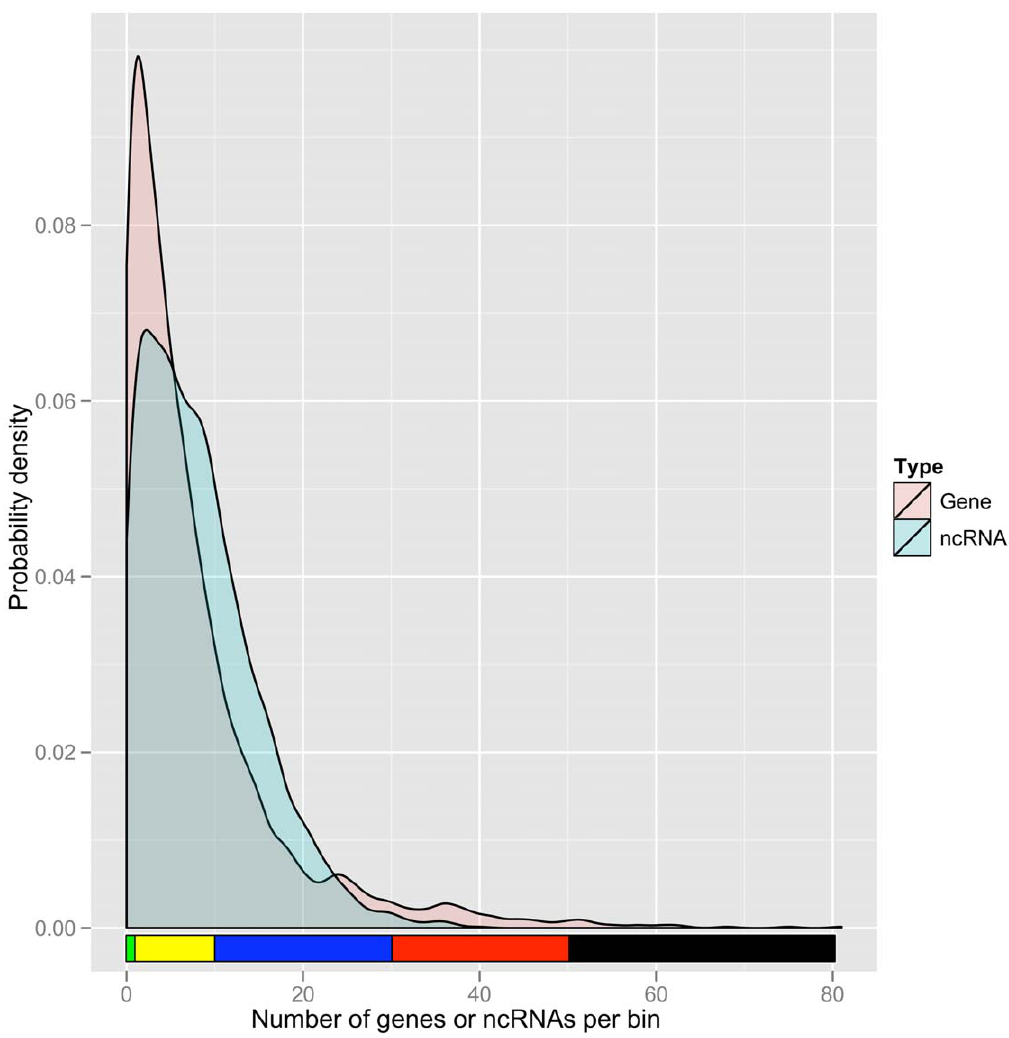
Figure 3. Probability densities of genes and ncRNAs per 1 Mb bin. NcRNAs have similar genomic densities compared to protein coding genes, but with fewer extreme density regions. The colour coding is consistent with Figure 2.